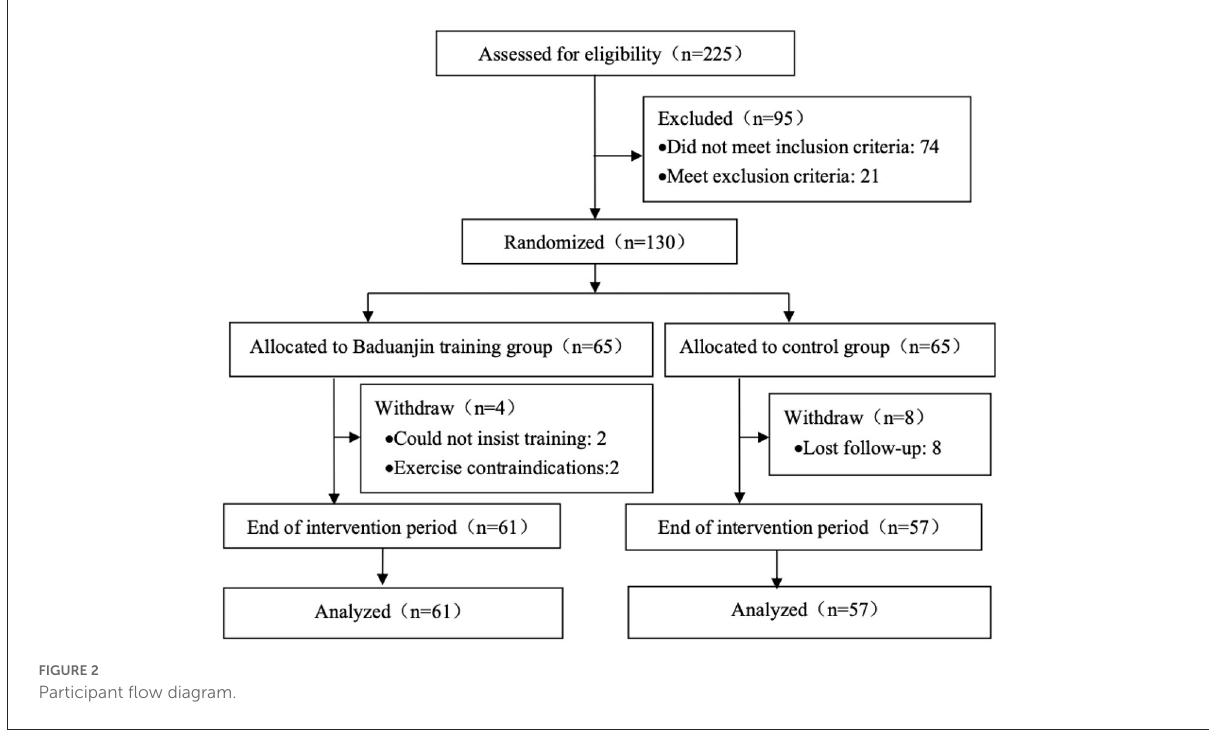
FIGURE2 Participant flow diagram.